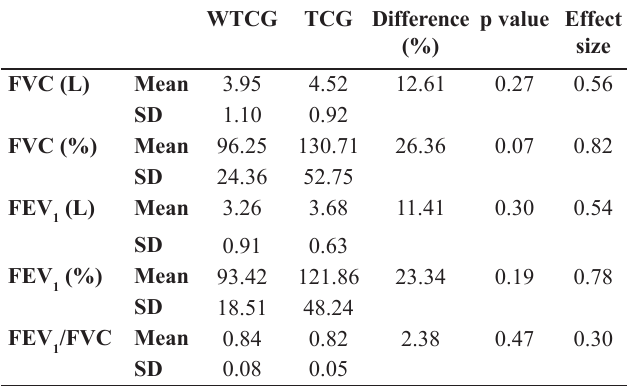
Table 2. Absolute and relative values obtained from the pulmonary function test.